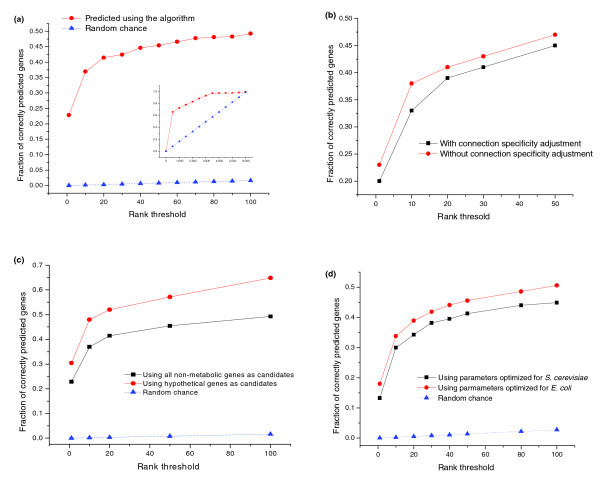
Enzyme predictions based on phylogenetic profiles. (a) The cumulative fraction of correctly predicted genes as a function of rank among all non-metabolic genes. All 6,093 non-metabolic yeast genes plus a known correct gene were ranked using Equation 2. The cumulative distribution is shown for ranks from 1 to 100; the inset shows the same distribution for all ranks. (b) The effect of connection specificity adjustment. Only highly ranked genes (1 to 50) are shown. (c) Comparison of the performance with all non-metabolic genes as candidates to that with only hypothetical genes as candidates for an orphan activity. (d) Predictions for the E. coli metabolic network. The cost function with the parameters optimized for the yeast network showed comparable performance to the cost function with the parameters specifically optimized for the E. coli network.